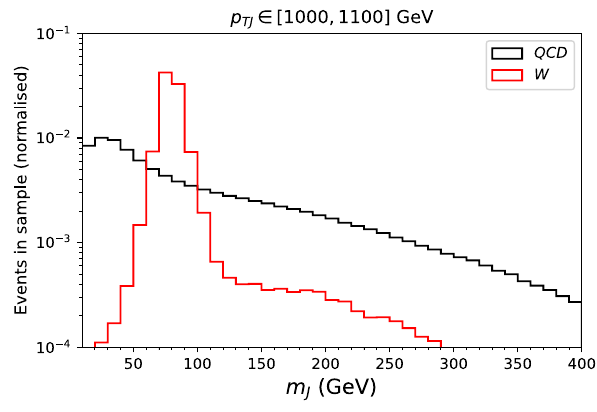
Fig. 2 Jet mass distribution for QCD and W jets with p T ∈ [ 1 , 1 , 1 ] TeV